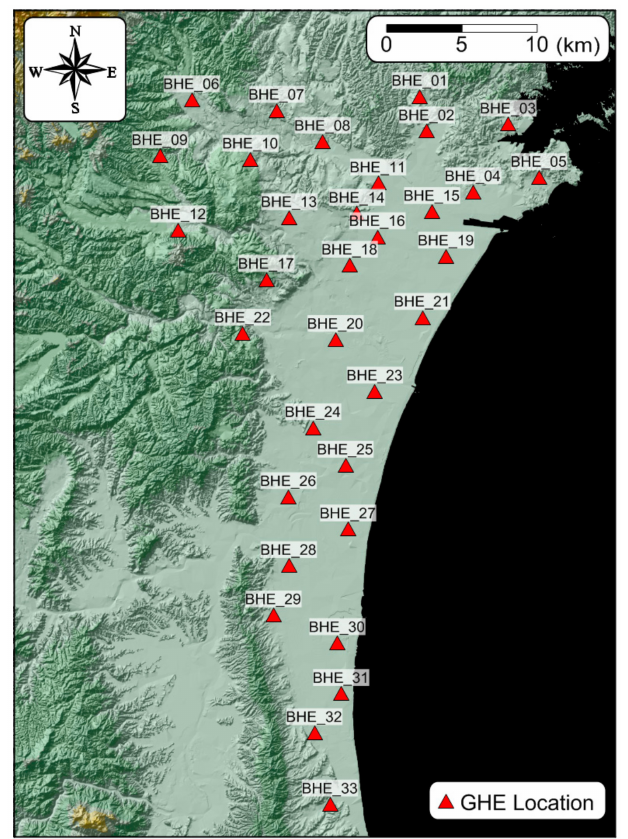
Figure 7. Locations of the ground heat exchanger (GHE)